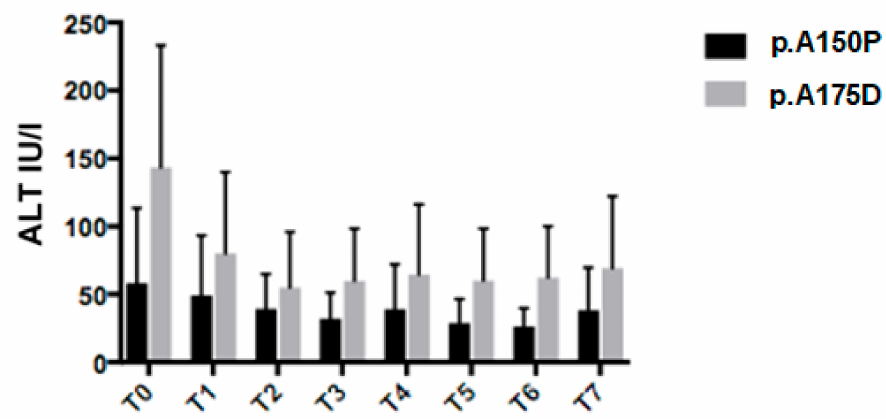
Figure 4. Alanine aminotransferase (ALT) values at di ff erent time points between p.A150P / p.A150P and P.A175D / P.A175D HFI patients. T0: time of diagnosis; T1: 6 months; T2: 12 months; T3: 18 months; T4: 24 months; T5: 36 months; T6: 48 months; T7: end of